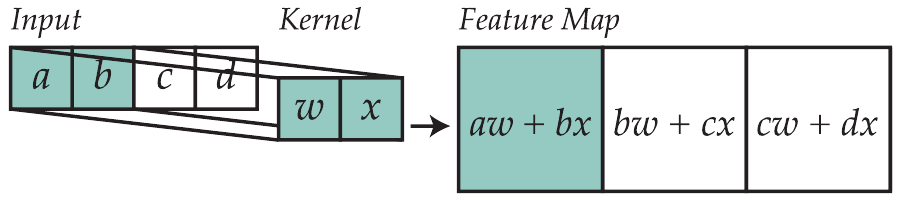
Figure 2. Example of how a 1D kernel is used to convolve the